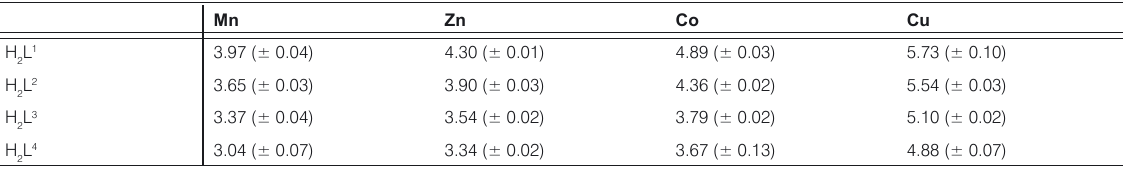
Table 5. The formation constants, log K , for the complexes of ligands with M(II), in methanol at 25˚C (I = 0.10 mol dm -3 ).